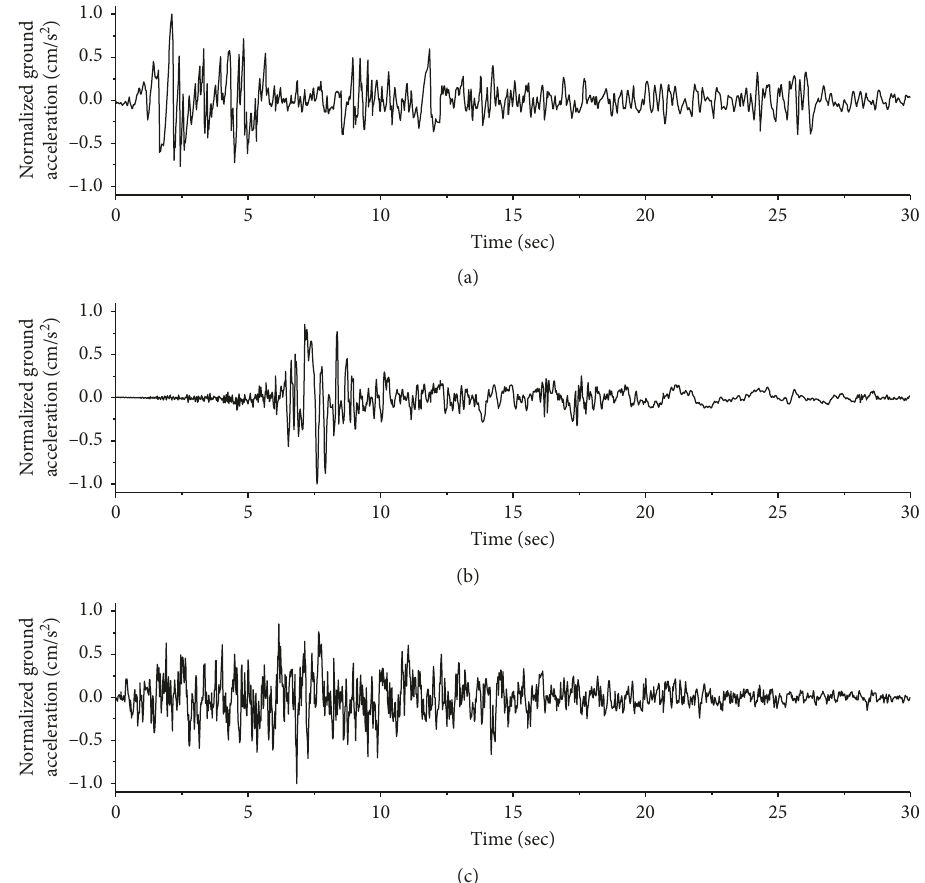
Figure 24: Earthquake records used in the incremental dynamic time-history analysis (a) El Centro earthquake NS components; (b) Imperial Valley record; (c) artificial ground acceleration.